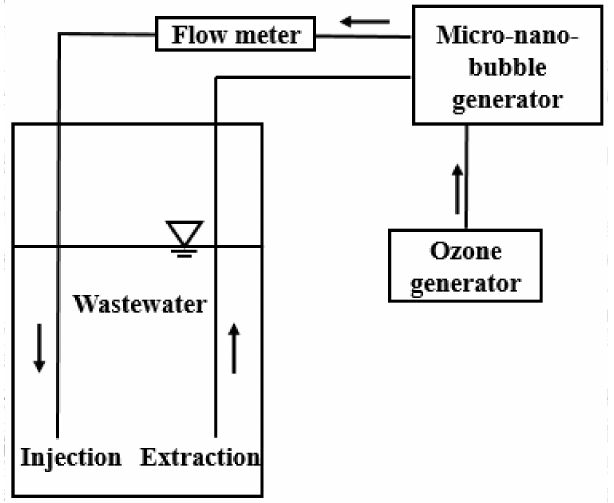
Figure 1. The schematic for wastewater treatment by ozone